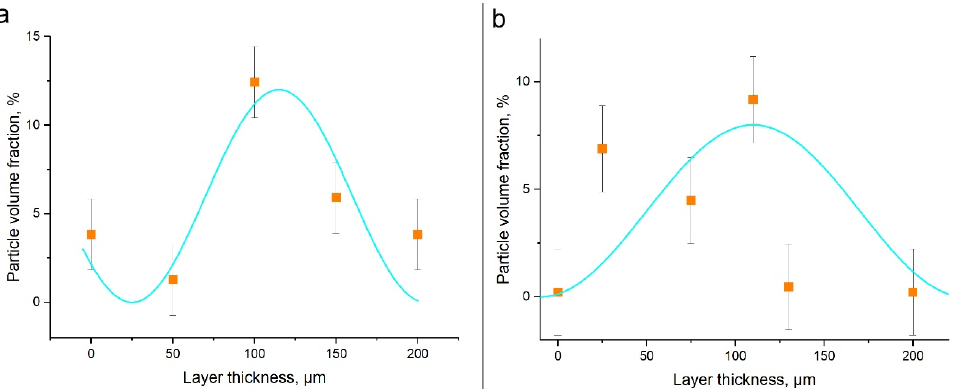
Figure 11. Volume fraction of secondary particles in the transfer layer in the FSW joint ( a ) and UAFSW joint ( b ). The blue color shows an approximation by a sinusoid.